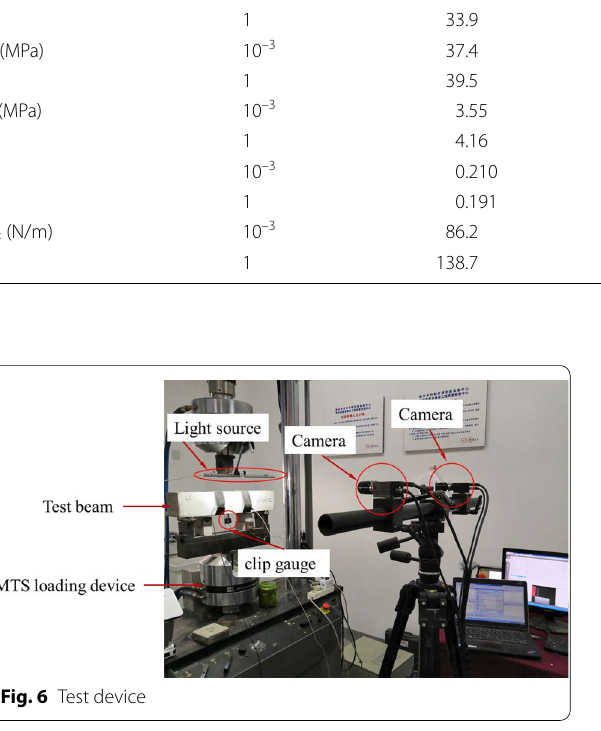
Fig. 6 Test device